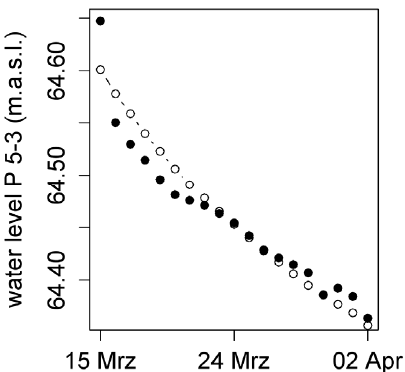
Figure 4. Comparison of observed (filled dots) and calculated (hollow dots) groundwater levels at the groundwater gauge P5-3 for the calibration period (15 March–2 April 2012). During the validation period, correlation between measured and modeled water levels at P5-3 was r 2 = 0.58 and the RMSE was 0.012 m. The model was able to simulate the overall recession in water level during the validation period but short time fluctuations could not be reproduced (Figure 5).